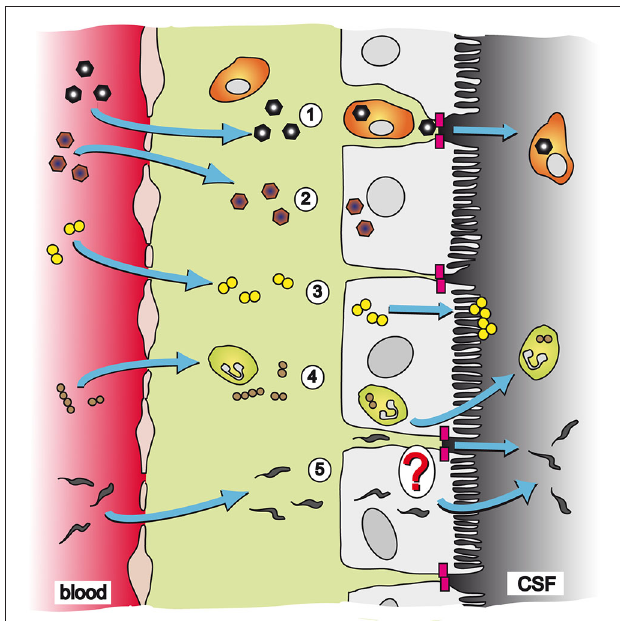
FIGURE 1 | Pathways and strategies of pathogen invasion into the CNS via the CP . The CP is an endothelial-epithelial convolute responsible for production of the CSF. Whereas the blood capillaries in the CP are fenestrated, the epithelial cells of the CP are connected to each other by TJs (magenta blocks) and present the morphological correlate of the BCSFB. (1) CVB3 has been described to cross the BCSFB inside of a specific population of myeloid cells, which is highly susceptible to infection upon traversal of the CP epithelial TJs; (2) EV30 can invade into CP epithelial cells and replicate inside the host cell; (3) The bacterium N. meningitidis can directly invade into CP epithelial cells. After transmigration through the cell layer N. meningitidis forms microcolonies at the apical cell side; (4) S. suis has been shown to invade into PMNs and crosses the BCSFB in a transcellular fashion employing a “Trojan horse” strategy; and (5) The parasite T. b. brucei can transmigrate through the CP epithelium to enter the CSF. The exact mechanism of translocation by T. b. brucei is not clear yet. It is hypothesized that the parasite follows a paracellular route after opening of TJs. Alternatively, T. b. brucei could directly invade CP epithelial cells for a transcellular